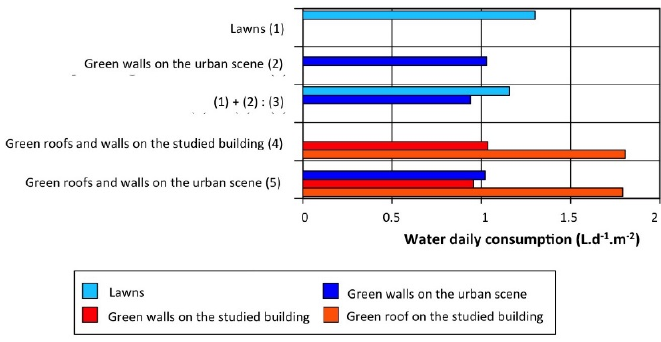
Figure 10. Mean daily water consumption of the various surfaces (in L ∙ d − 1 ∙ m − 2 ).